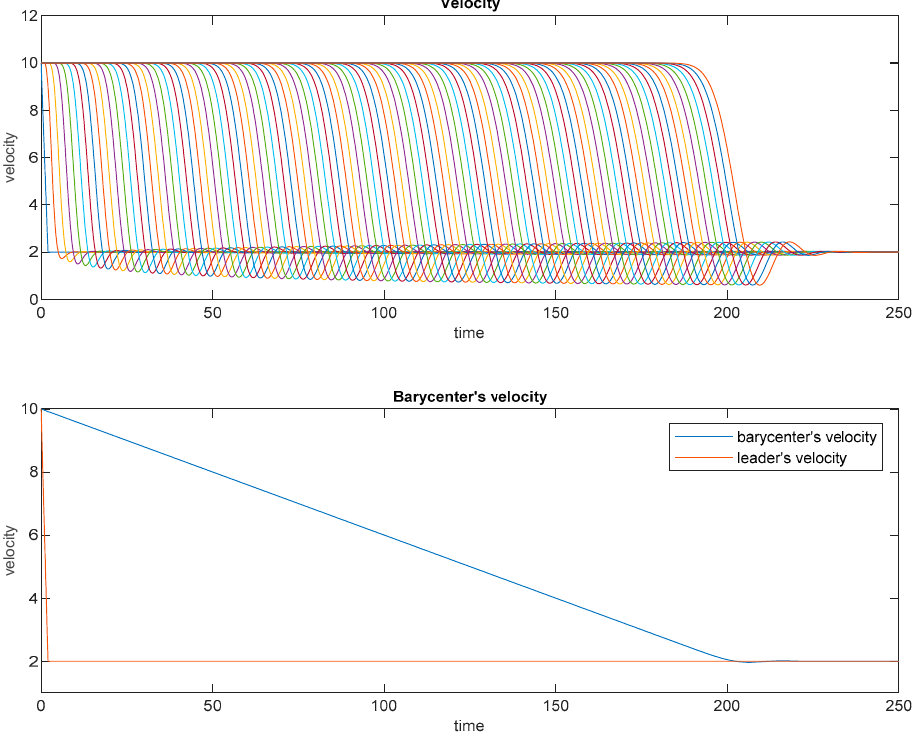
Figure 14. The standard model simulated with b = 20 m and excited by the braking maneuver imparted by the leader Equation (15); symbolism is the same in Figure 10.